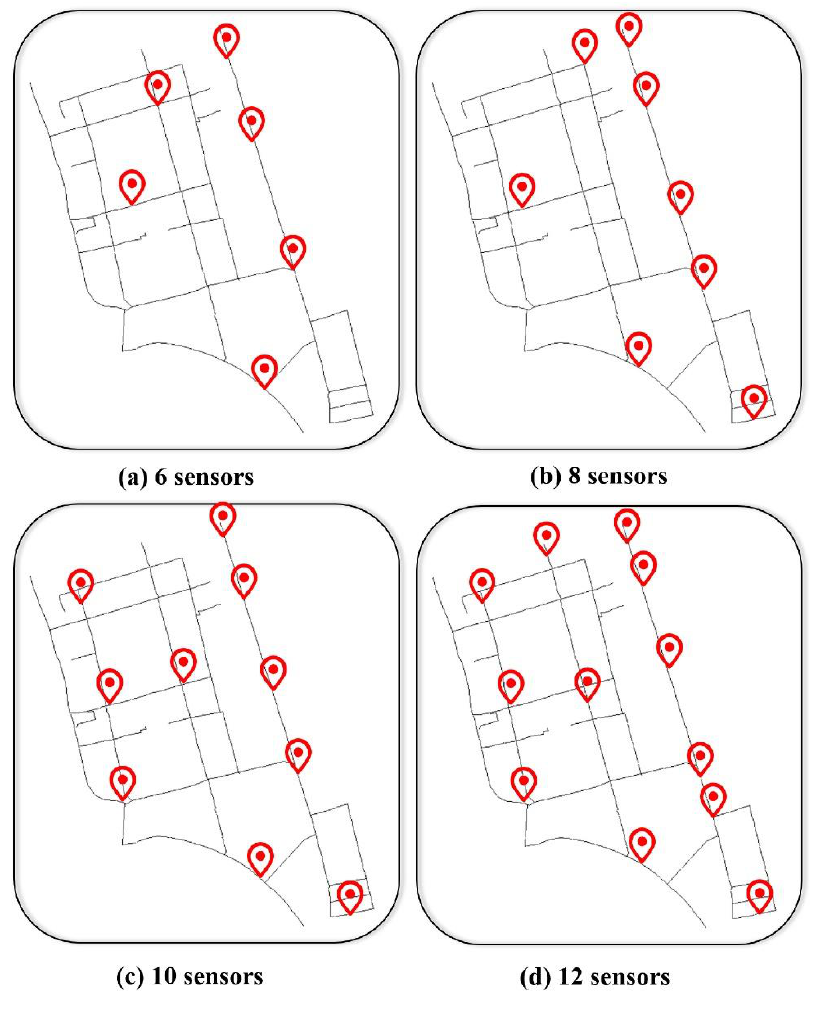
Figure 8. Pressure sensor arrangement for the K-means clustering approach.